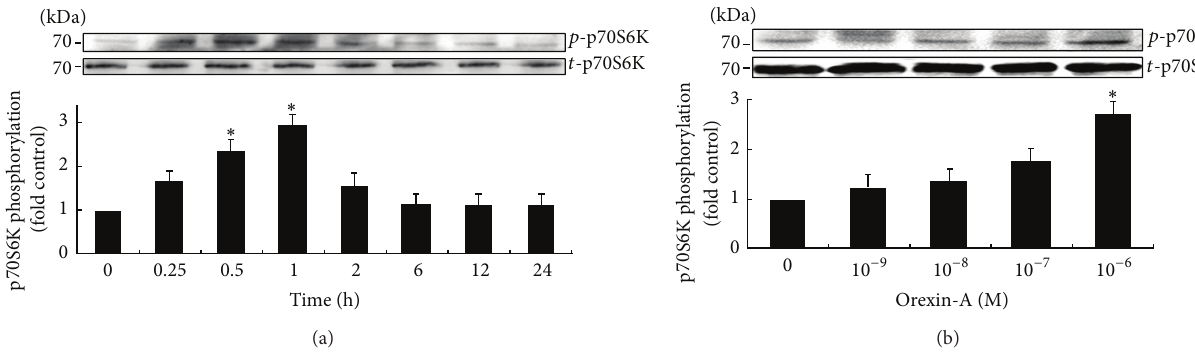
Figure 1: Orexin-A stimulates the p70S6K activity in H295R cells. Cells were stimulated with orexin-A (10 −6 M) for the indicated time periods (a) or orexin-A (10 −9 M–10 −6 M) for 1h (b). The expressions of p70S6K protein were measured via western blot analysis. Data are presented as mean ± SEM based on three independent experiments. Asterisk indicates significant differences as compared to control ( ∗ 𝑃 < 0.05 ).